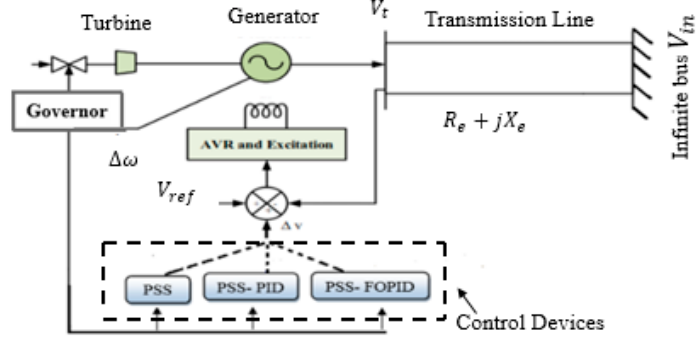
Figure 1. Schematic line diagram (SMIB) system [10].